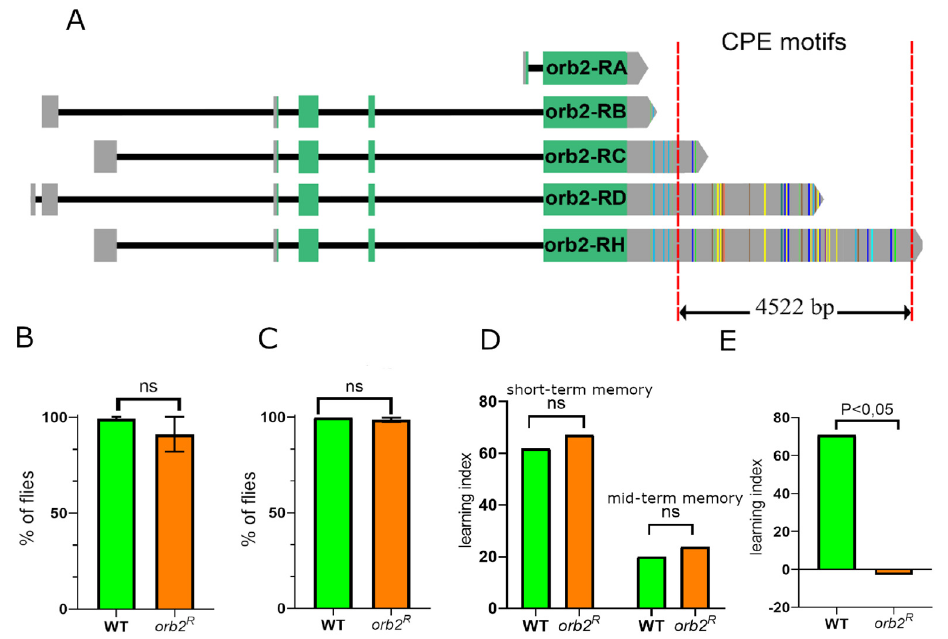
Figure 1. Influence of the orb2 3’UTR deletion on fly locomotion and memory formation. ( A ) Schematic representation of orb2 mRNAs. The vertical-colored lines in the 3 ′ UTR (gray region) show the CPE sequences. Different colors of lines correspond to different CPE sequences (see [26] for details). The red dashed lines show the deleted part of the 3 ′ UTR. ( B , C ) The percentage of WT and orb2 R flies that could climb after strong shaking (climbing assay, B ) and restore the normal body position after intense shaking (vortex assay, C ). The standard deviation is shown, t -test, n = 100; ns – nonsignificant ( D , E ) Learning indices of WT and orb2 R flies as calculated for short-, mid- ( D ), and long-term ( E ) memory by assessing the suppression of male sexual behavior after interaction with a previously fertilized female. Assessment of differences between learning indices based on calculated courtship indices (two-side randomization test, p < 0.05, n = 20).